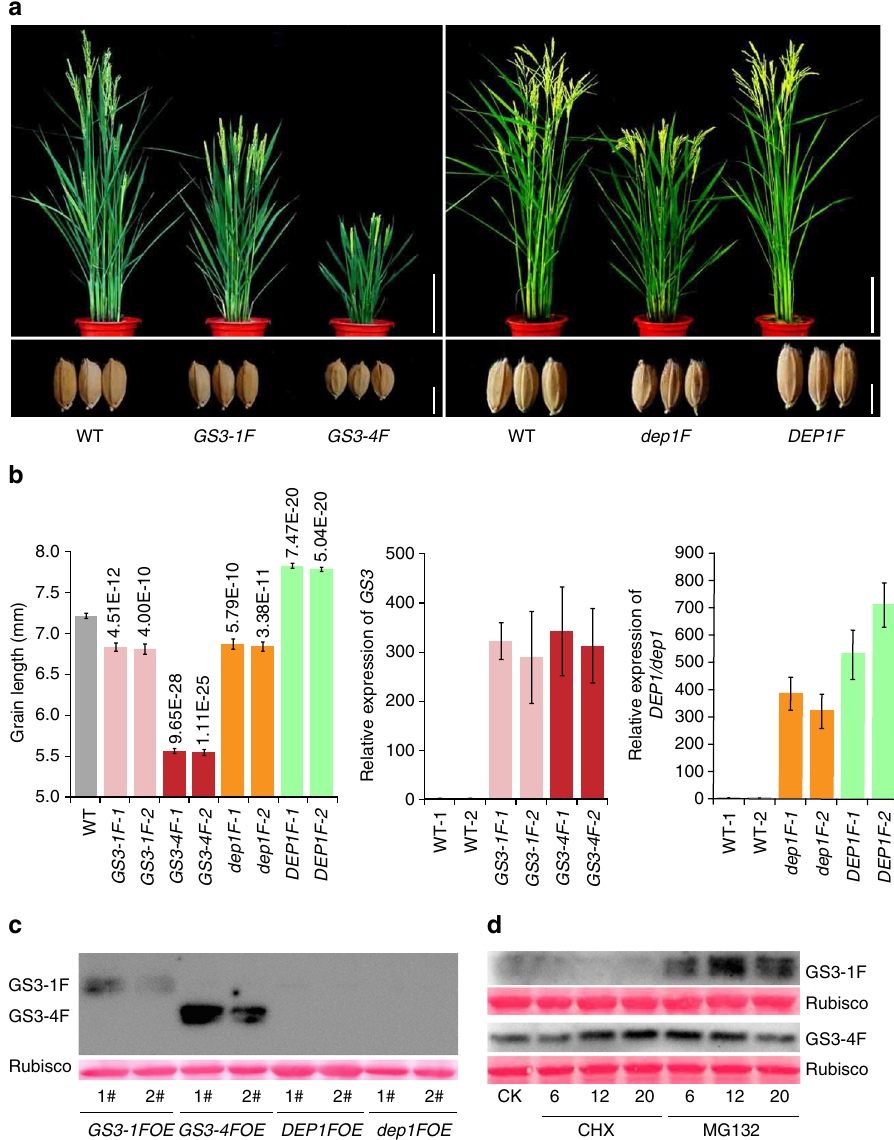
Fig. 4 Immunoblot analysis of the proteins in transgenic plants with Flag tag. a Whole plants and grains in WT (wild type ZH11), and transgenic plants of Ubi :: GS3-1 : Flag ( GS3-1F ), Ubi :: GS3-4 : Flag ( GS3-4F ), Ubi :: dep1 : Flag ( dep1F ), and Ubi :: DEP1 : Flag ( DEP1F ). Plant, bar = 20 cm; grains, bar = 5 mm. b Grain length and relative expression levels of the genes in transgenic plants. Values for grain length are given as mean ± SEM ( n = 10). P values are given on the top of the bars, which are based on two-tailed t -tests. Values for expression analysis are given as mean ± SEM ( n = 3). c Immunoblot analysis of the transgenic plants. Total proteins are extracted from the shoots of 15-day-old seeding, and 20 μ g amount was used for western blotting. d Immunoblot analysis of Flag fused GS3-1 and GS3-4 proteins after the treatments with 30 μ M CHX and 50 μ M MG132. CK, the GS3-1F and GS3-4F transgenic plants without treatment. CHX, Actidione. The two bands of GS3-1 protein are likely due to protein modi fi cation by ubiquitination. The numbers (6, 12, 20) indicate hours after the homolog GmDEP1 in Daohuaxiang2 (DHX), a variety lacking functional GS3 . AGG3, ZmGS3 and GmDEP1 contained short tail sequence, with 50%, 49% and 48% of protein identities to DEP1, and 45%, 74%, and 33% identities to GS3-1. The transgenic plants overexpressing DEP1 produced expected longer grains. And